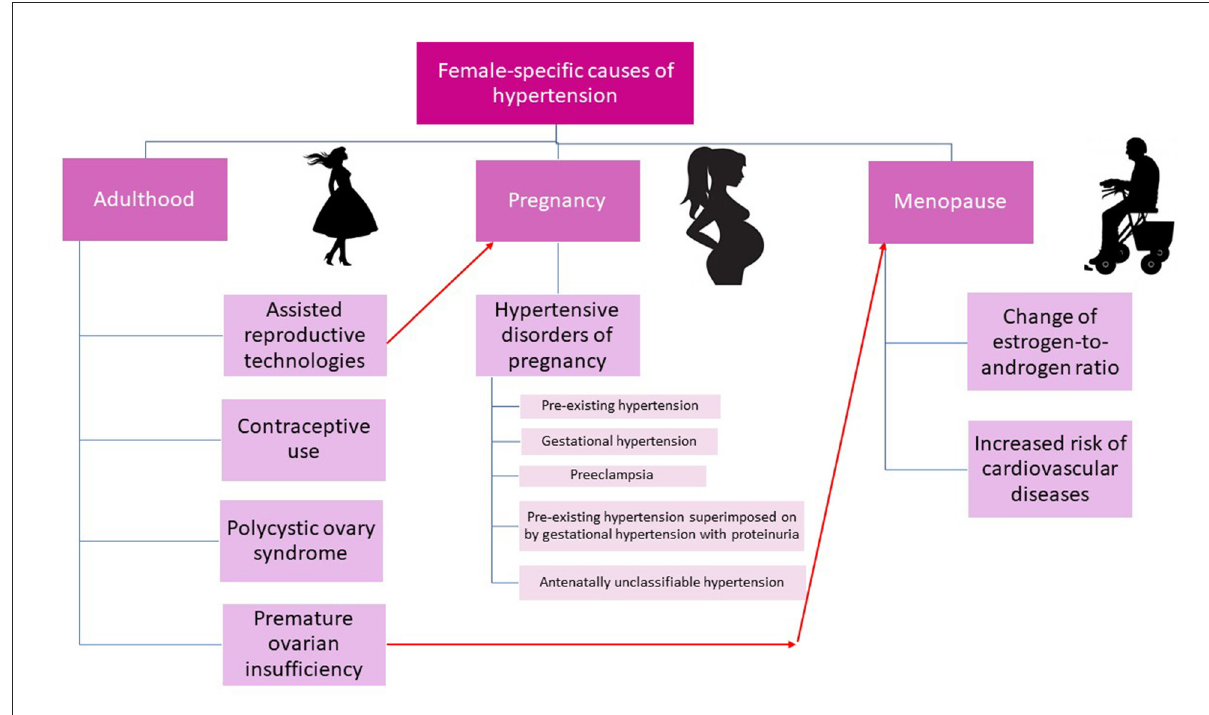
FIGURE2 Female-specific causes of